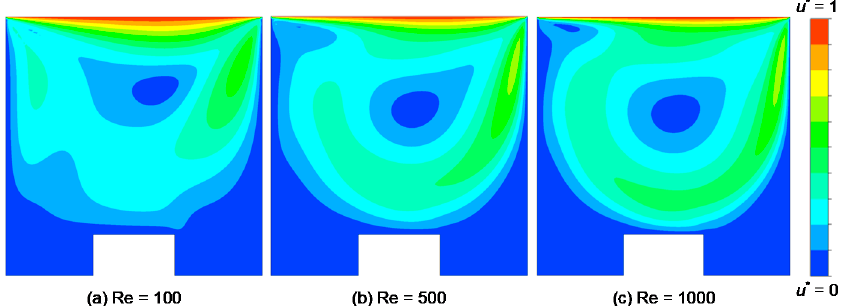
Figure 11. Dimensionless velocity contours for three different Reynolds number for H 1 / L 1 = 0.5 and Ra = 10 5 for the fin area fraction of 0.05 and an Al 2 O 3 -volume fraction of 1%. ( a ) Re = 100; ( b ) Re = 500; ( c ) Re = 1000. Inventions 2018 , 3 , x